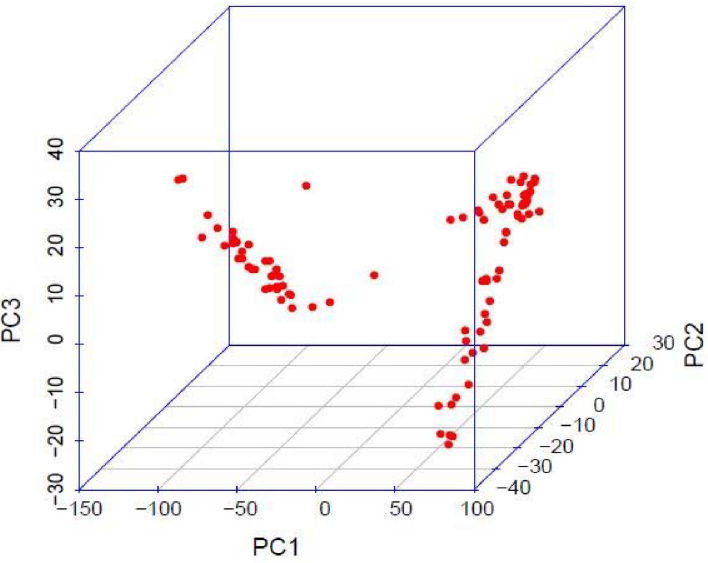
distributed across the 11 chromosomes. For BDS, the markers were identified on chromo- somes Pv01 , Pv06 , Pv07 , Pv08 , and Pv10 (Table 4; Fig 4A). Chromosomes Pv06 and Pv08 had three markers each that had a significant association with BDS. Markers M3381188 on Pv01